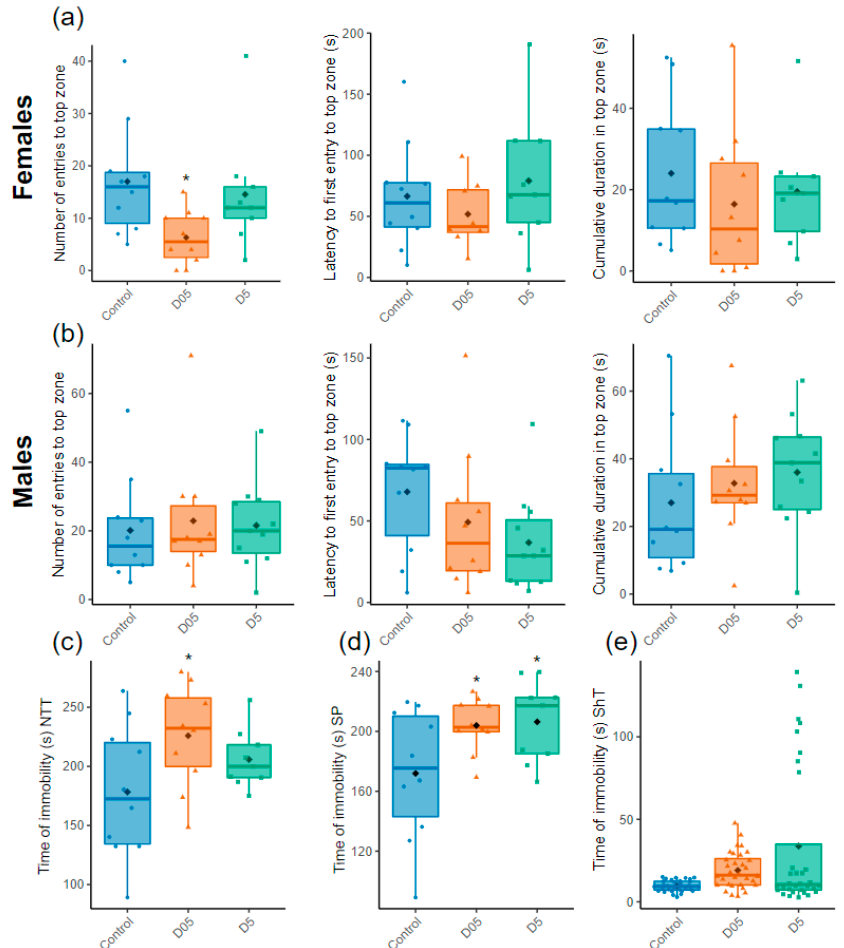
Figure 4. Assessment of stress behavior. ( a ) Number of entries, latency to first entry and time spent in the top zone in the novel tank test (NTT) for females and ( b ) males ( n = 9–11). ( c ) Time of immobility of females in the NTT ( n = 9–10), ( d ) the Social Preference test (SP) ( n = 9–10 females or males) and ( e ) the Shoaling test (ShT) ( n = 32 both females and males). Data are represented by mean (black point), median (horizontal line), ±75th and 25th percentiles and analyzed with negative binomial mixed effect models ( a , b , left panels) or Gaussian linear effects models ( a , b , middle and right panel, c , d ) or Gamma generalized linear mixed models ( e ). * p < 0.05.